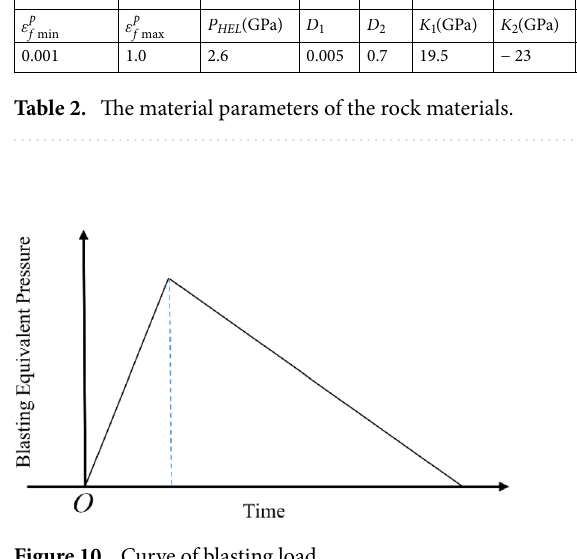
Figure 10. Curve of blasting